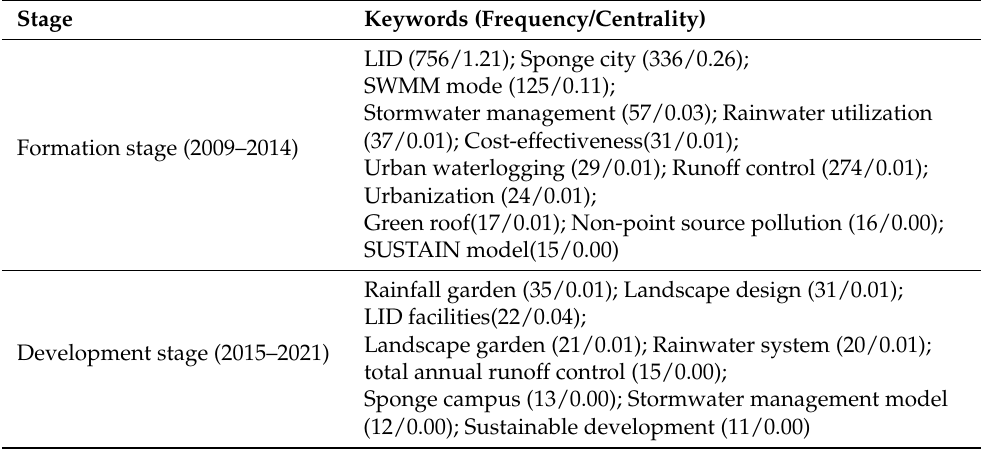
Table 8. The high-frequency keywords of publications according to the CNKI database. Stage Keywords (Frequency/Centrality)